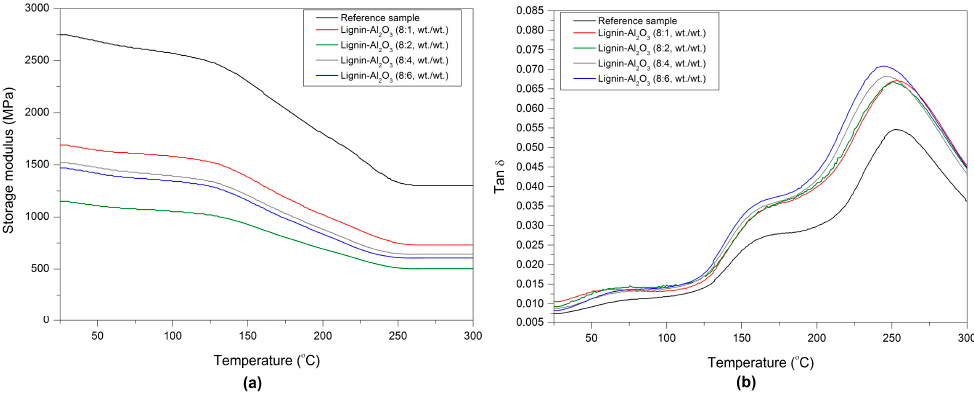
Figure 10. Storage modulus G ′ ( a ) and tan δ ( b ) versus temperature for the composites obtained.